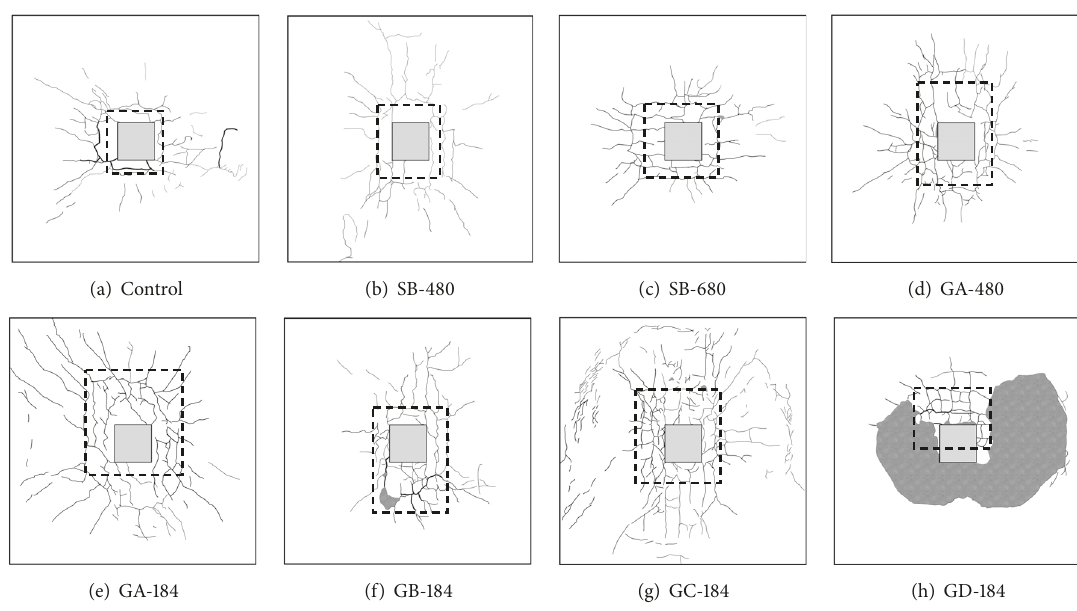
Figure 8: Crack patterns on the slab tension side of each